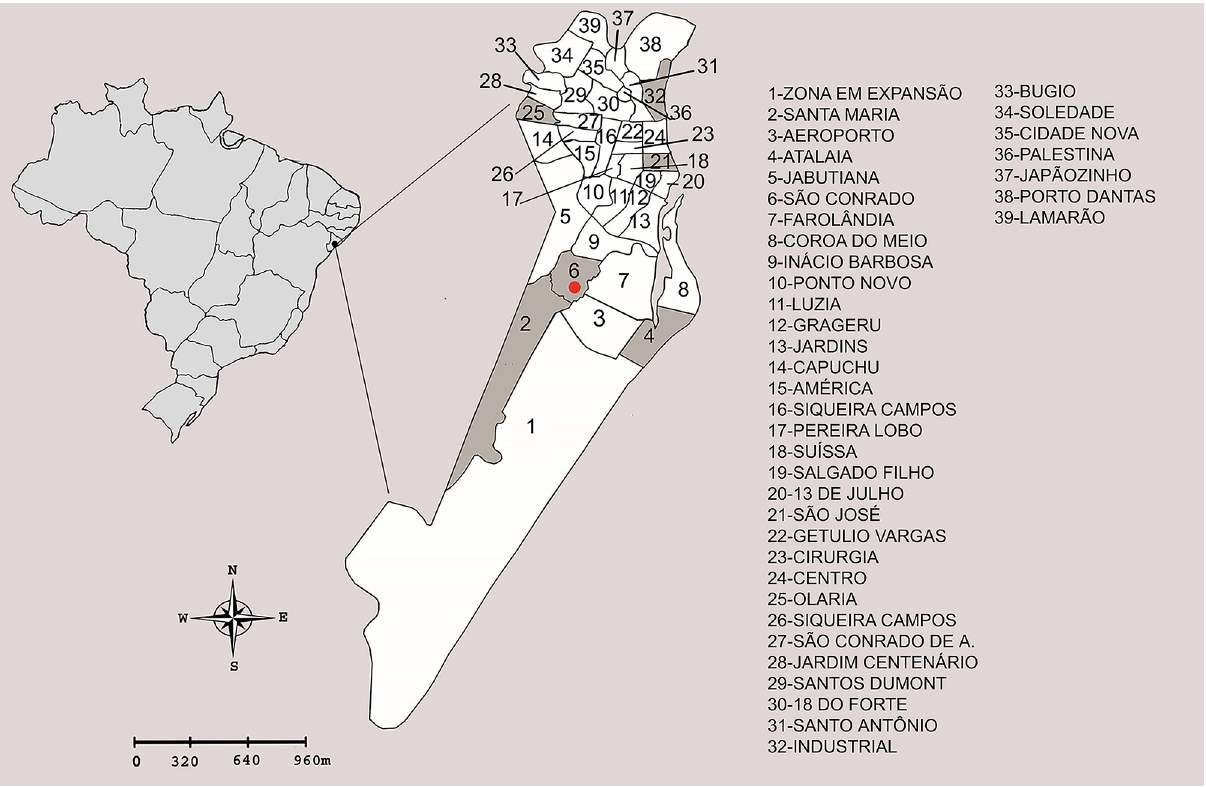
Fig 1. Map of the Aracaju city and neighborhood boundaries. The neighborhoods where mosquitoeswere collectedare shaded in gray. The red dotted neighborhood is where CHIKV-positive Ae . aegypti were collected.